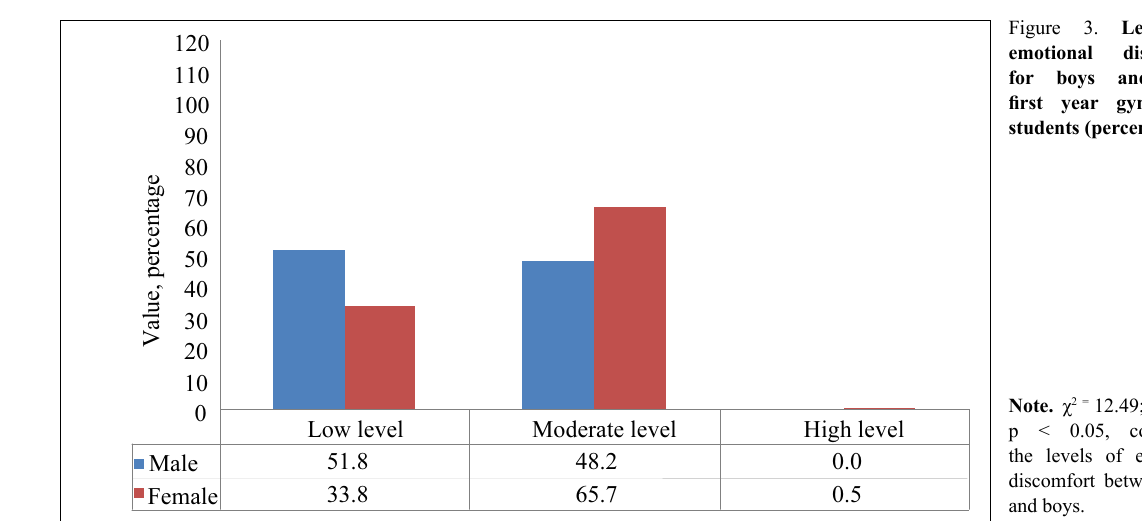
Figure 2. Levels of negative evaluation of others for boys and girls, first year gymnasium